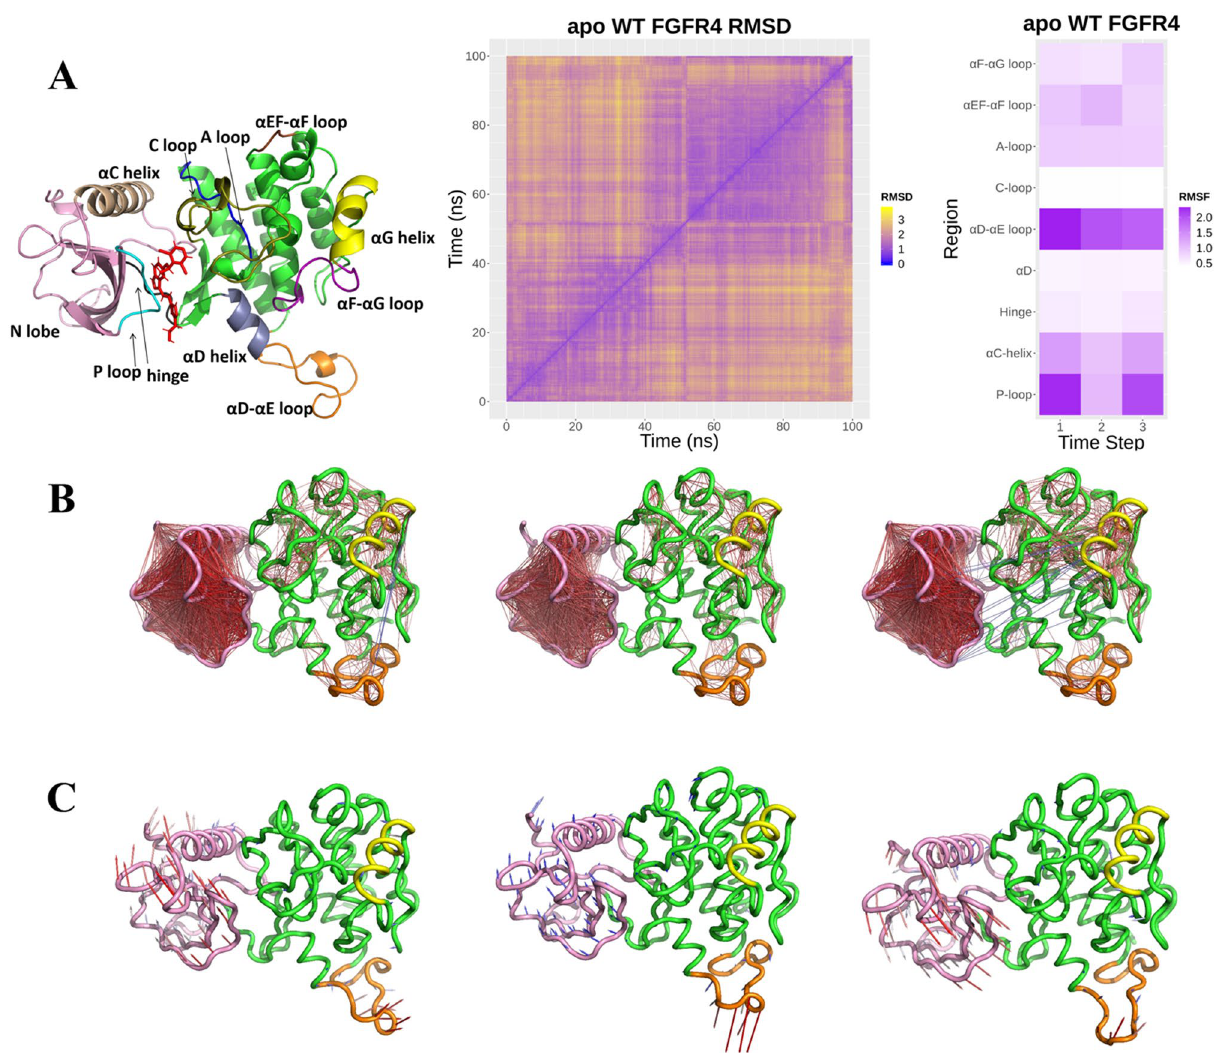
Figure 1. The apo-WT FGFR4 is in search of its substrate. ( A ) 6LF-WT FGFR4 structure, representing the protein moiety we used as the input structure for the simulation systems. 6LF is in red sticks. FGFR4 protein regions are colored as: N-lobe in pink, αG helix in yellow, αD–αE loop in orange, αF–αG loop in purple, αEF–αF loop in brown, A loop in olive, C loop in blue, P loop in cyan, αC helix in wheat, hinge in black, αD helix in gray, and other residues in green. ( B ) pairwise RMSD heat map. Based on this, the apo-WT-FGFR4 simulation was divided into three steps: 0–50, 50–90, and 90–100 ns. ( C ) Time stepped RMSF heat map. This indicates the most fluctuations in the αD–αE loop, αG helix, and P-loop regions. ( D ) Dynamics cross-correlation representation. Residues with highly correlated or anti-correlated motions are linked by a red or blue line, respectively. ( E ) PC1 motion. Arrows indicate the direction and contribution of the residues in the protein’s significant conformational highlighted in yellow in Supplementary Table 2. Residues of P-loop, hinge, αD helix, and A loop are involved in binding free energy of both WT and mutant complexes. The most important differences in binding patterns are related to E22, N104, L166, and R182 (all are highlighted in blue in Supplementary Table 2). E22 from P-loop has significantly more contribution in WT compared to mutant complex. Furthermore, the N104 from αD helix shows more contribution in the V550L mutant complex. The R182 is only involved in the binding of the WT, while L166 is only contributed to V550L mutant complex binding energy. Therefore, the comparison of apo systems with 6LF-liganded systems shows that 6LF binding, causes the rigidity of hinge and αD helix regions. Free decomposition energy analysis shows that this region, in both WT and V550L, strongly interacts with 6LF. Also, P-loop, A-loop, hinge, and αD helix regions participate in the stabilization of 6LF in both WT and V550L complexes.